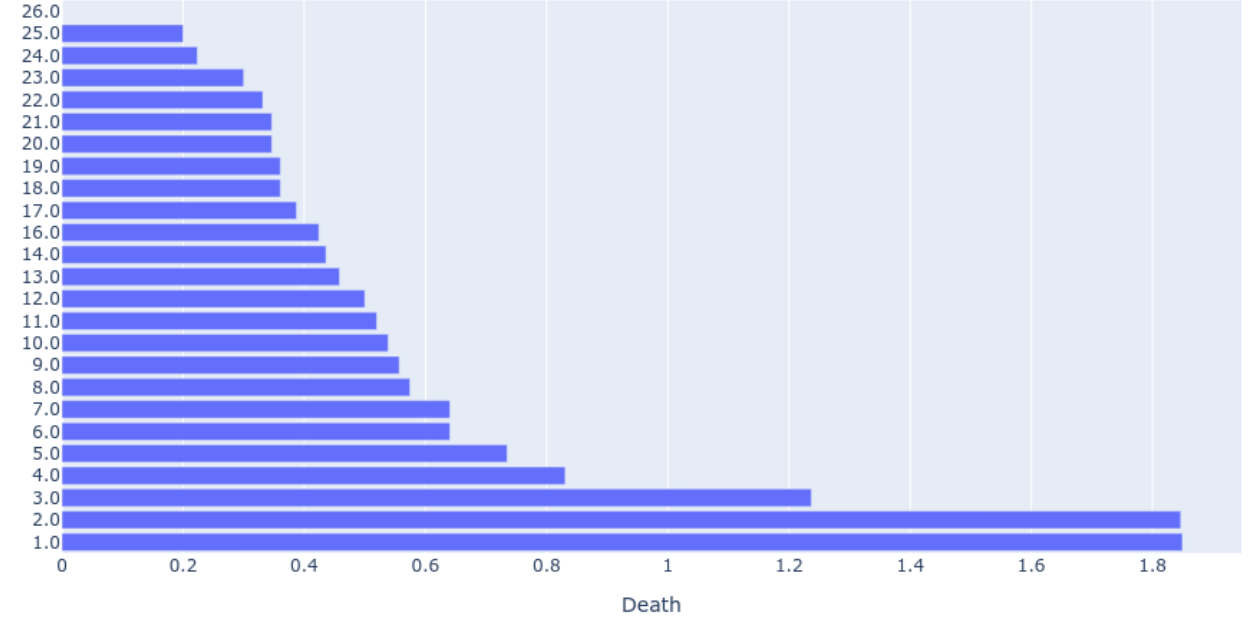
Figure 7. Bar Code result from 0-dimensional Homology analysis in NodeMCU 8266 platform. The analysis was obtained by randomly sampling 32 samples from the IRIS dataset.